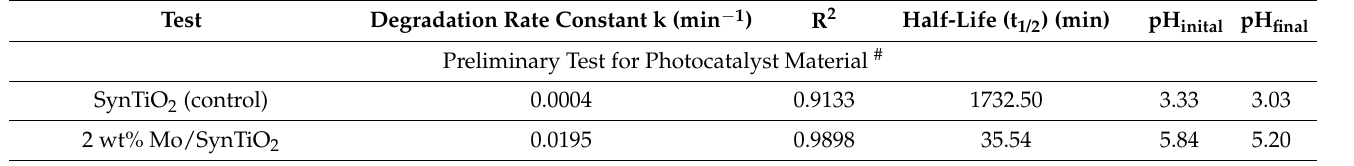
Table 4. Tested photocatalytic parametric indicators effect over photocatalytic degradation of CBZ under 365 nm UV irradiation and their related degradation rate constant k (min − 1 ), correlation coefficient R 2 , half-life t 1 / 2 (min), and initial and final pH